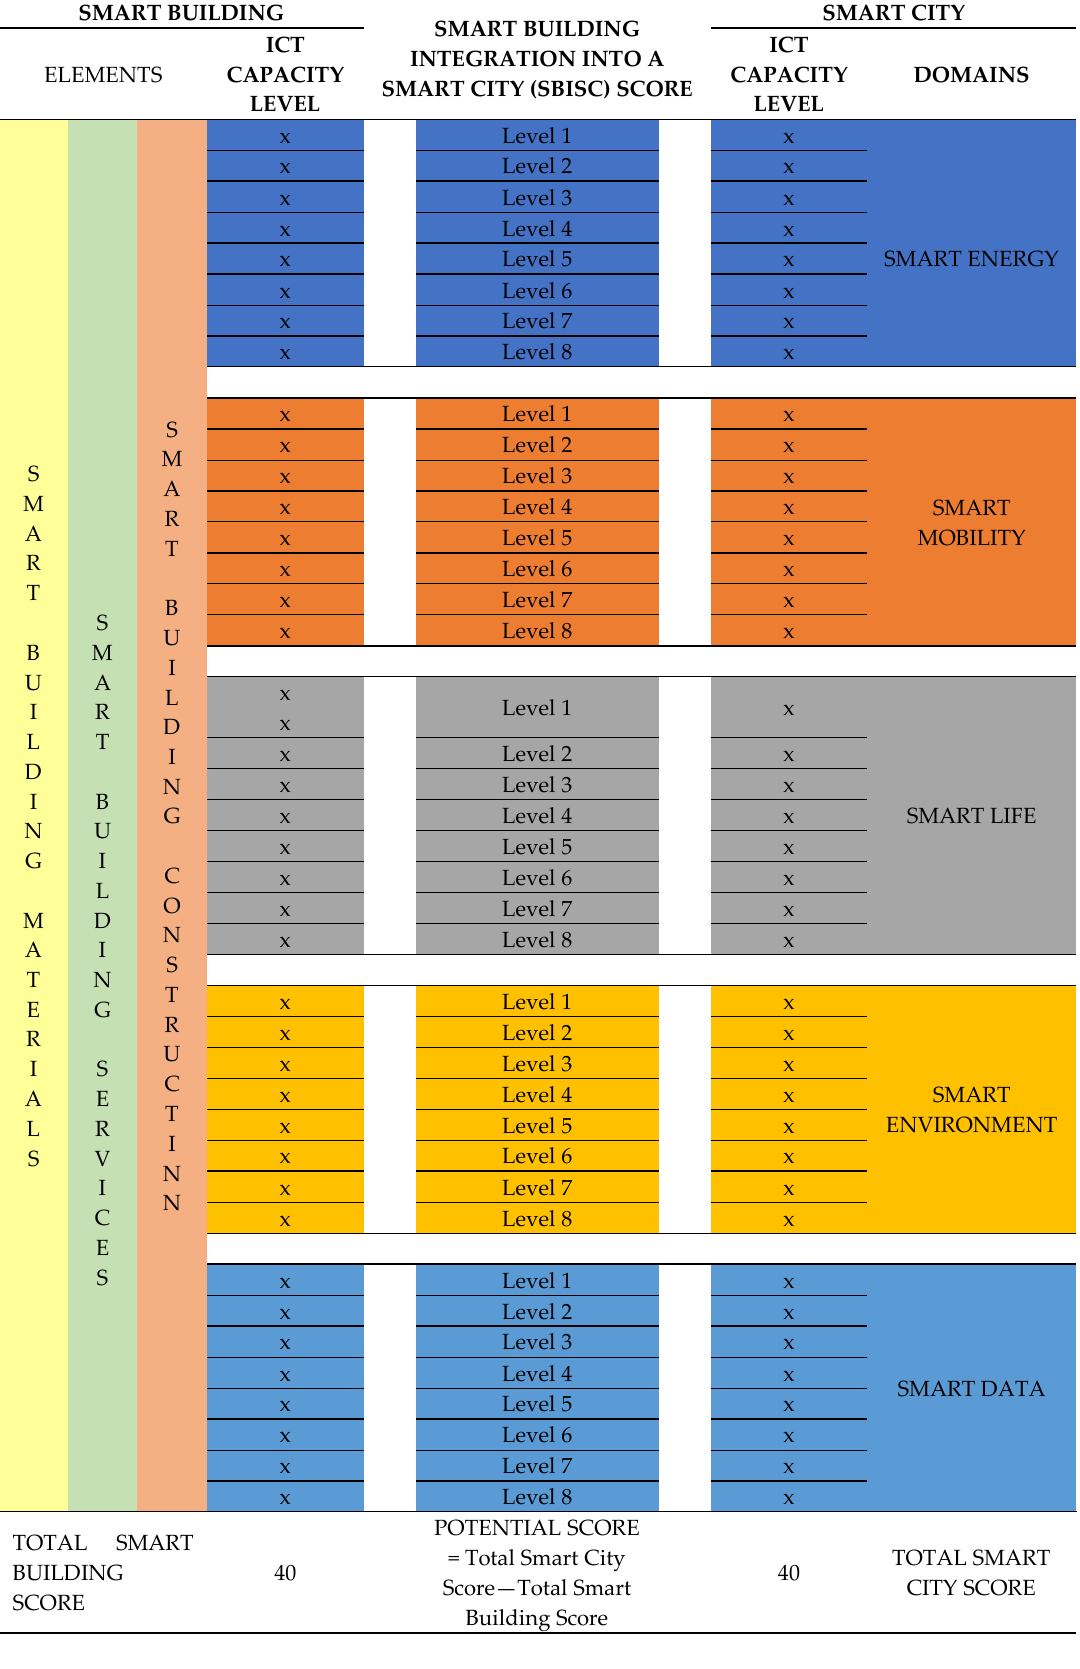
Table 9. Smart Building Integration into a Smart City (SBISC) framework.